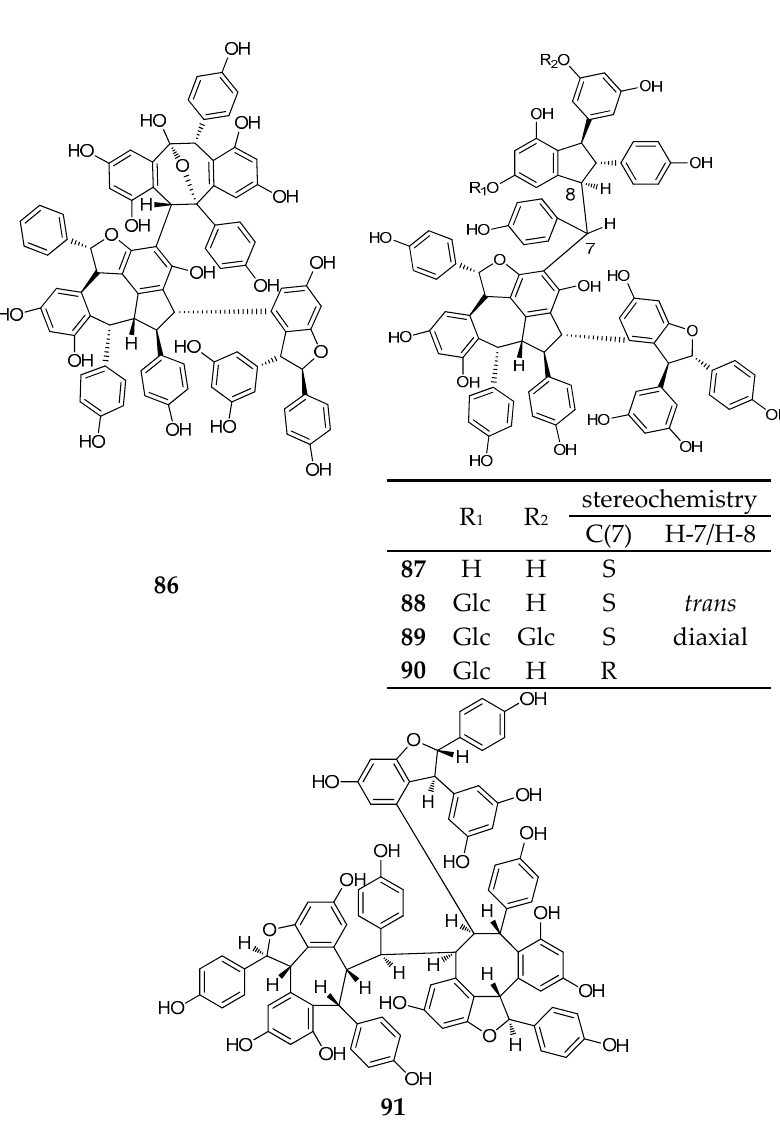
Figure 7. The structure of resveratrol hexamers ( 86 – 91 ).